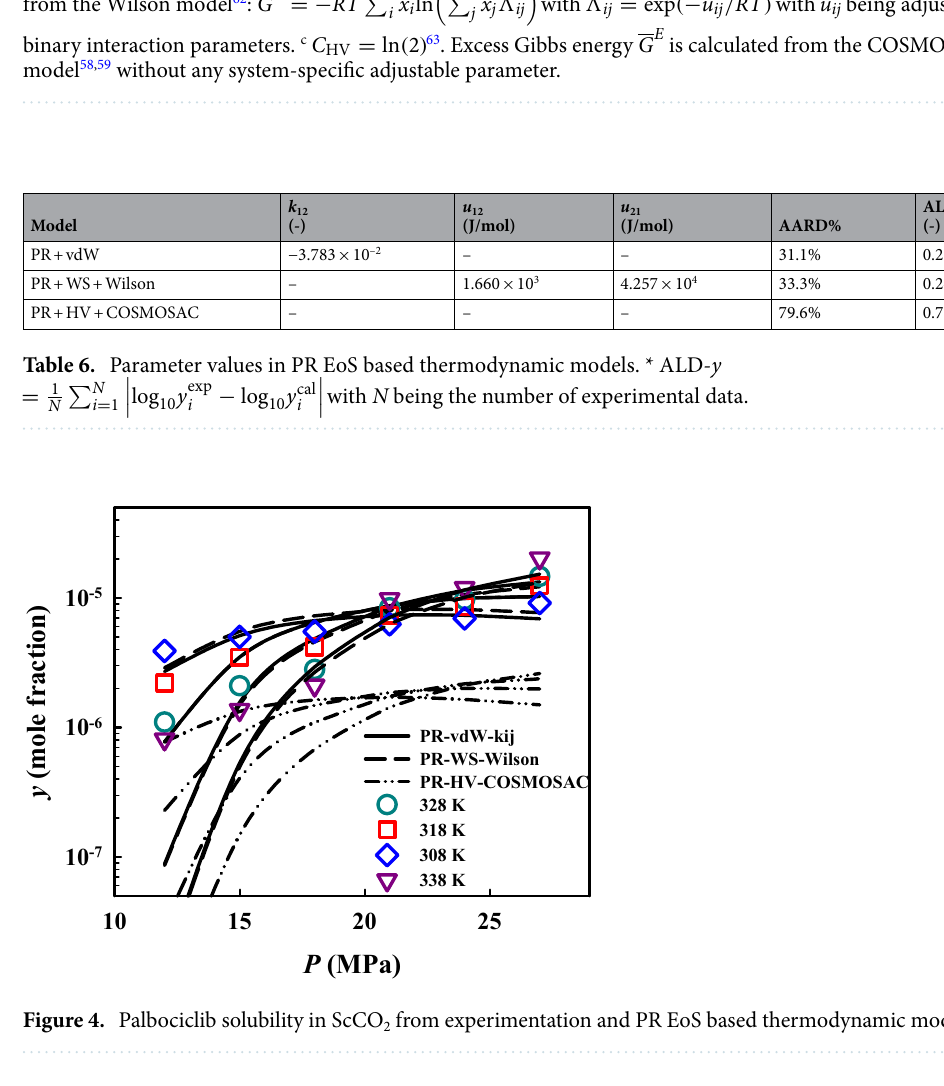
√ √ / 2 − 1 2 60,61 . Excess Gibbs energy is determined (cid:31) (cid:30) E = − RT x i ln x j (cid:31) ij with � ij = exp ( − u ij / RT ) with u ij being adjustable i j (cid:30) (cid:31) (cid:29) (cid:31) E is calculated from the COSMOSAC